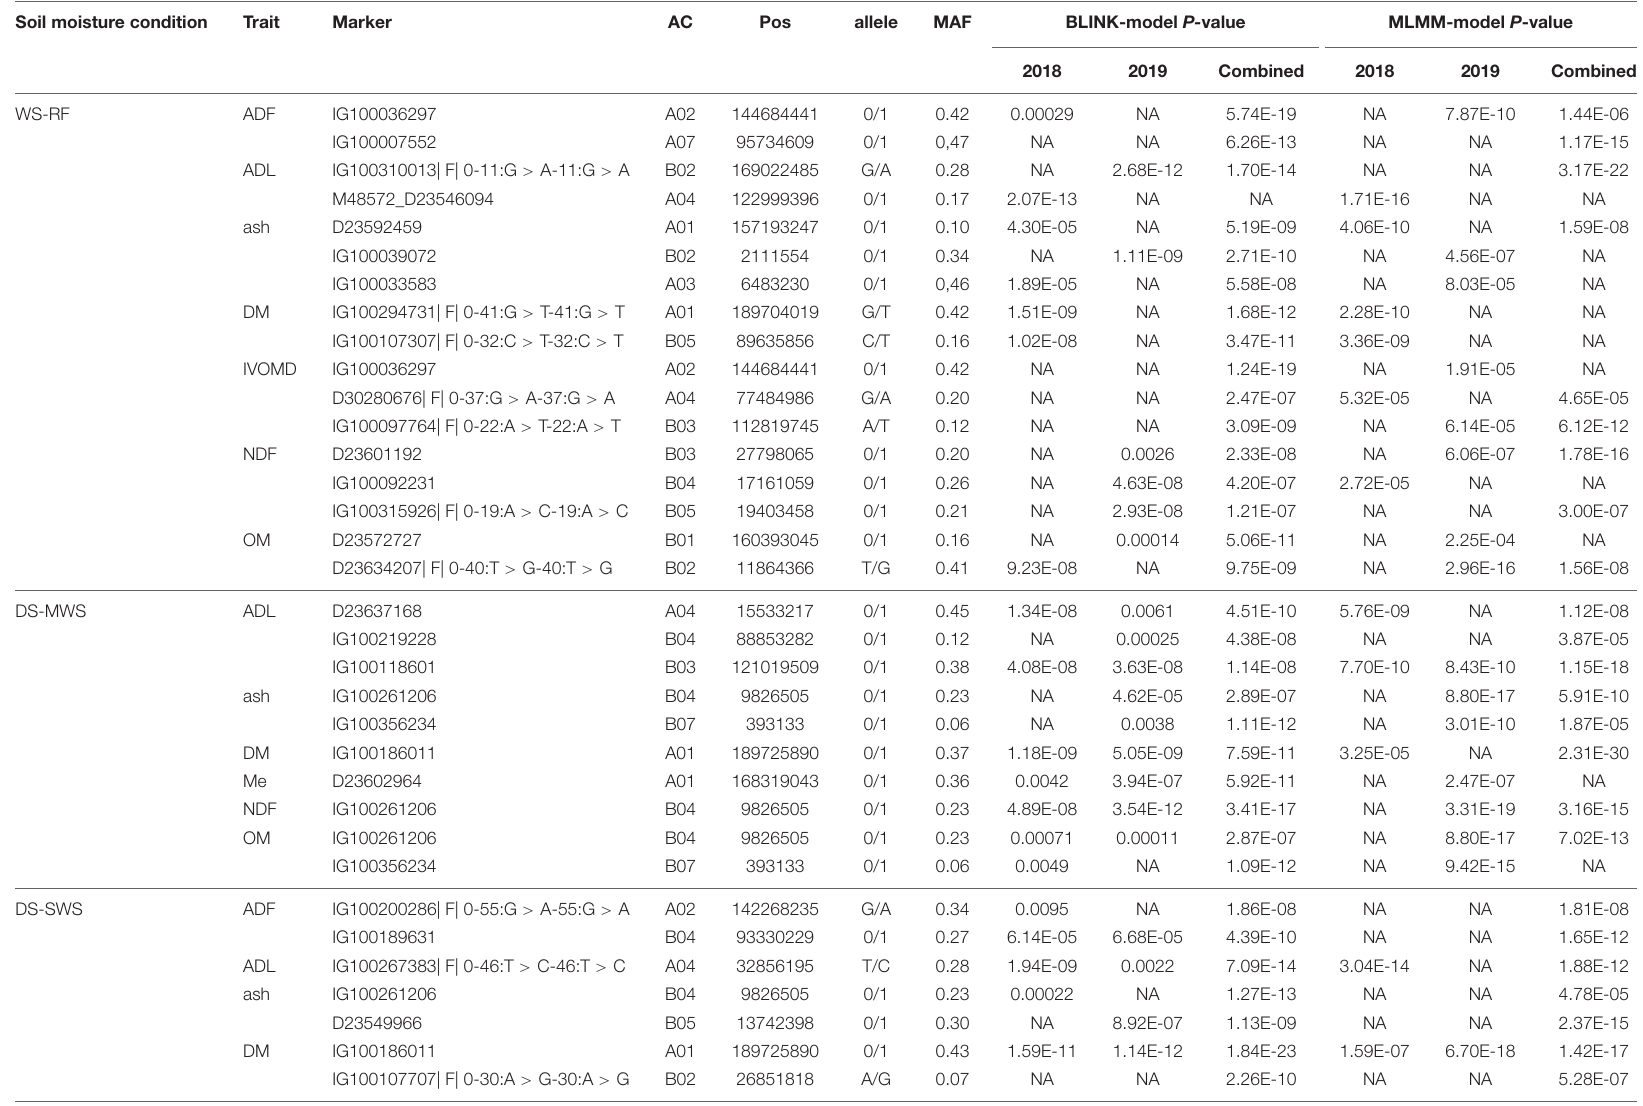
TABLE 5 | Markers significantly associated with the feed quality traits, their genomic positions, contrasting alleles, and minor allele frequency (MAF). Soil moisture